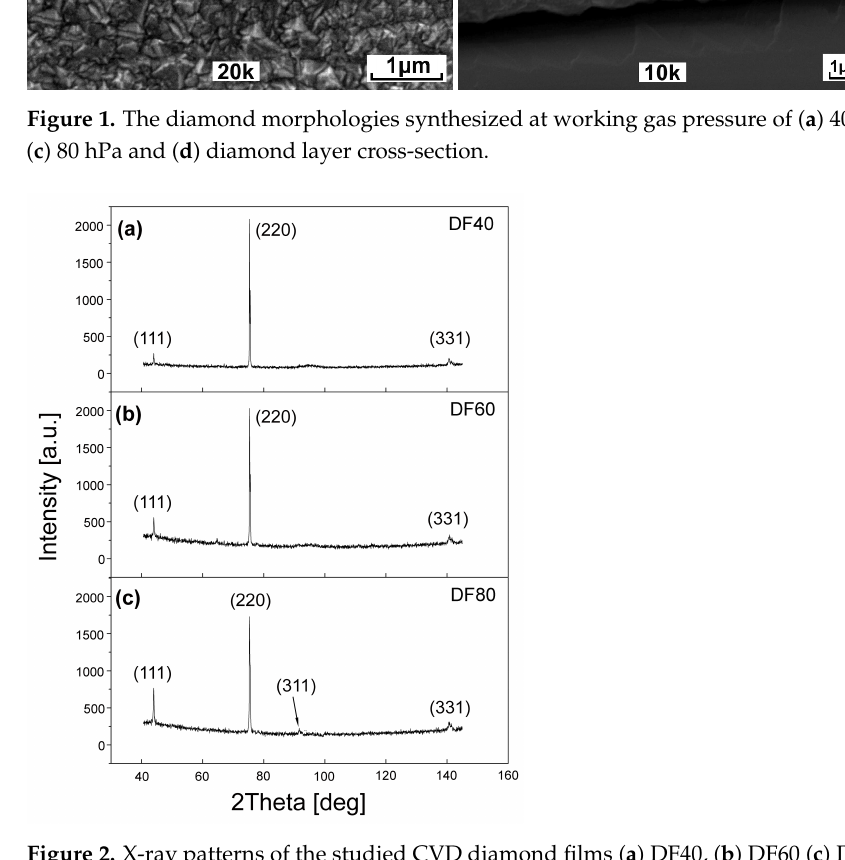
Figure 2. X-ray patterns of the studied CVD diamond films ( a ) DF40, ( b ) DF60 ( c )